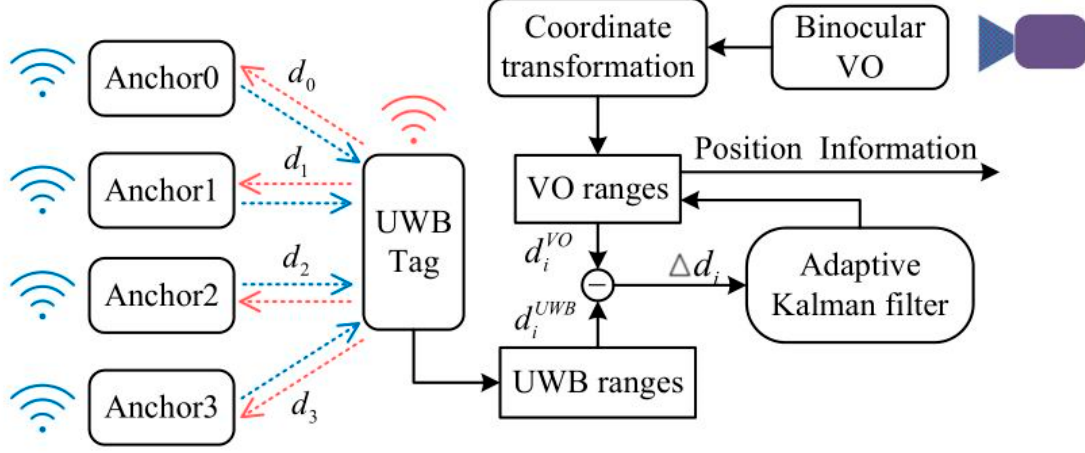
Figure 6. Data fusion system diagram.